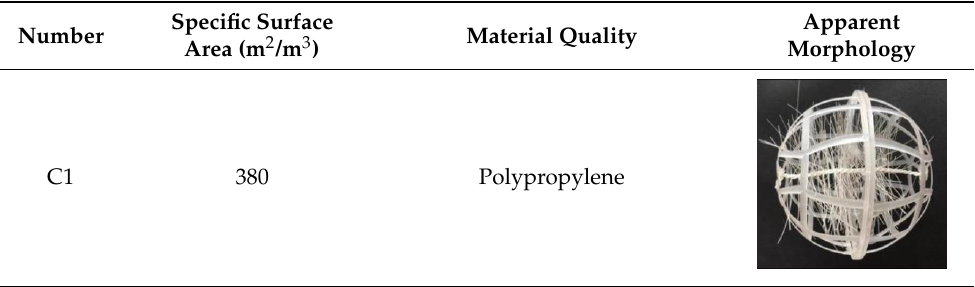
Table 1. Specific surface area data of different carriers.